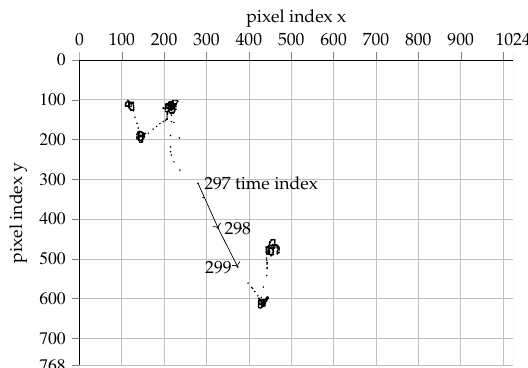
Figure 1 . Trajectory in screen